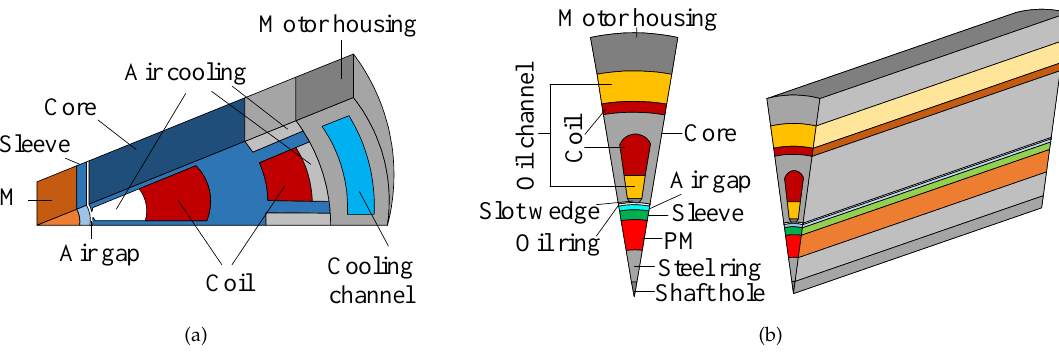
Figure 16. Structure of stator opening internal and external cooling channels: ( a ) Hybrid cooling model for toroidal windings; ( b ) Oil cooling model.